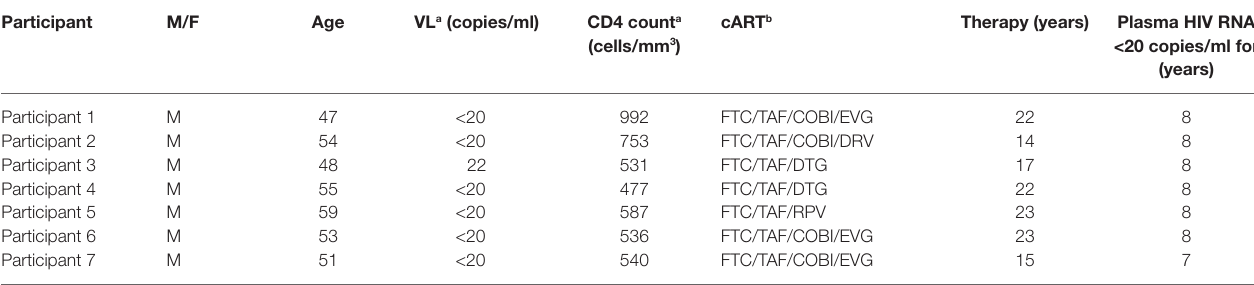
TABLE 1 | Clinical characteristics of HIV + participants of this study.